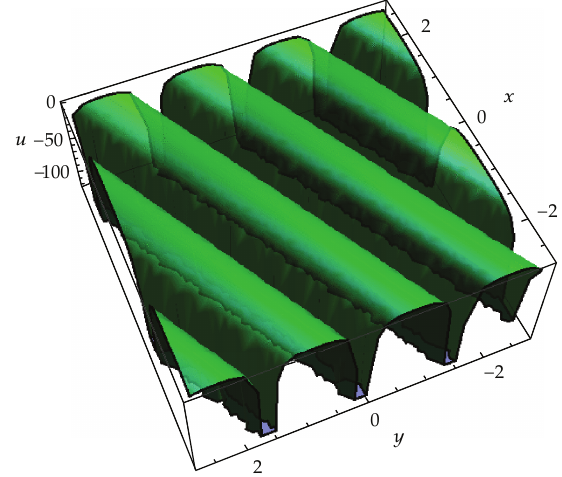
Figure 3: Evolution of travelling wave solution (19) with parameters 𝑡 = 0, 𝜔 = 0.2, 𝜌 = −1.12